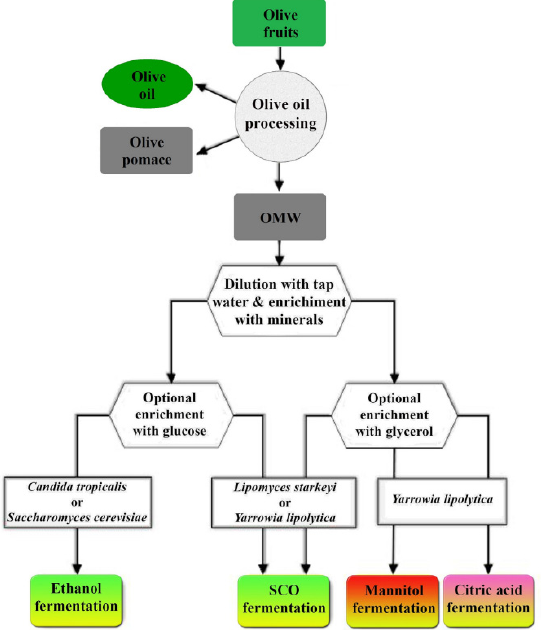
Figure 8. Flow chart for OMW conversion into different microbial products. Reprinted with permis- sion from Reference [14]. Copyright 2016. Elsevier.